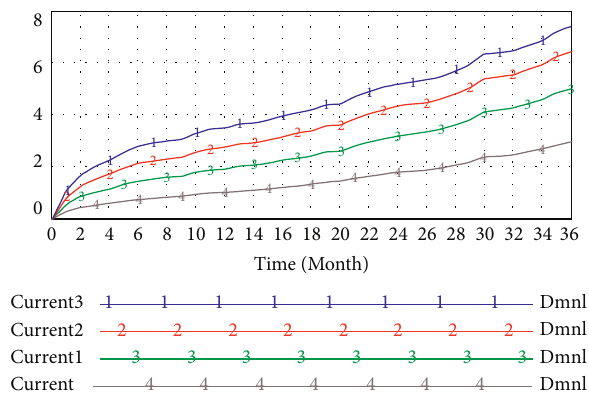
Figure 5: The simulation diagram of the relationship between network relationship capability and knowledge transfer quantity of the knowledge